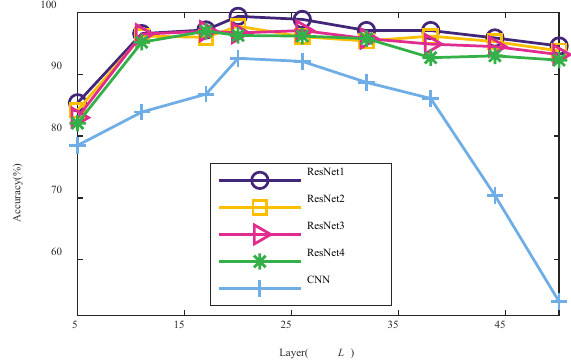
Figure 6. Effect of the network layers on accuracy. Table 2. Network parameter.